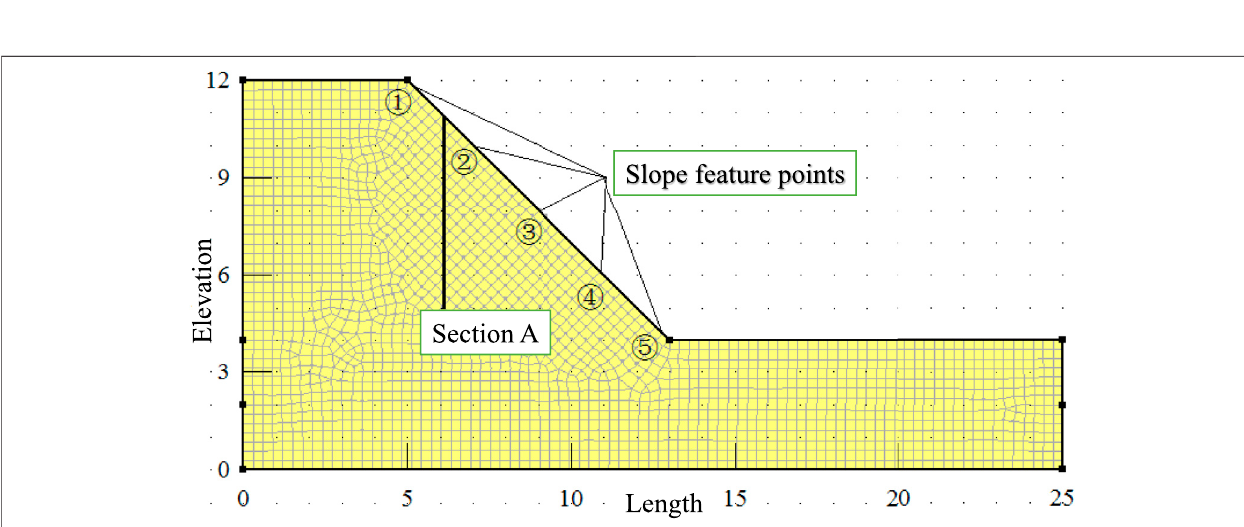
FIGURE 8 | The shear strength behaviour of SB mixed silt under different vertical pressures. (A) Fitted curves of the shear strength of SB under different vertical pressures. (B) Shear strength fi tted surfaces of SB mixed silt.